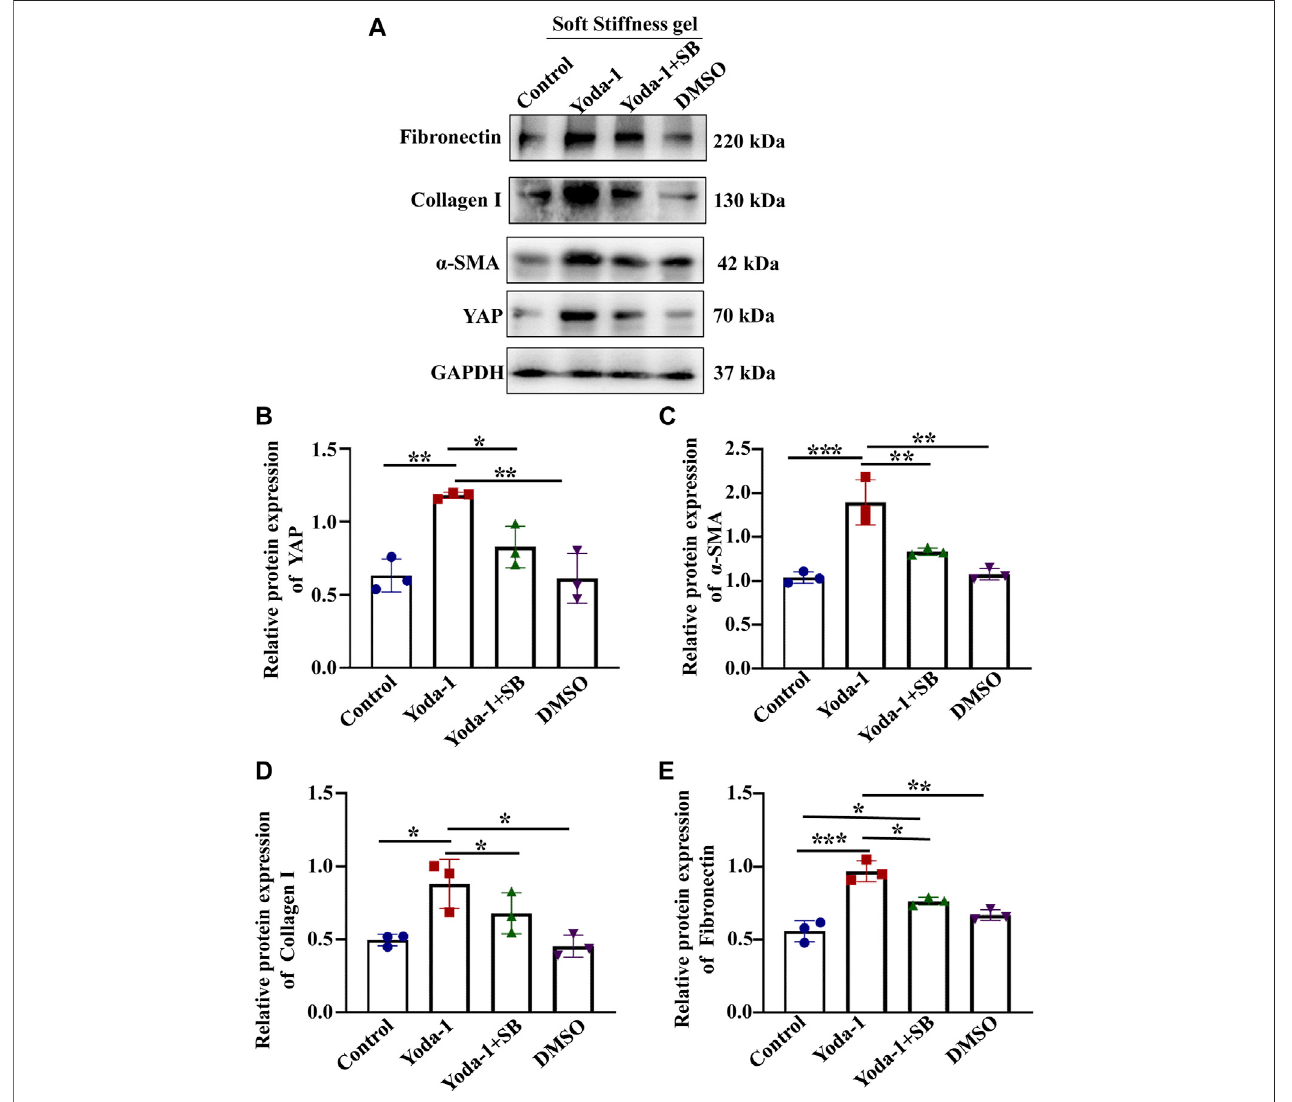
FIGURE7| p38MAPKinhibitor reducedtheincreasedYAPexpressionandECMsecretioninducedbyPiezo1activator. (A) MCswereincubated withYoda-1and SB for 48 h on the soft gel. (A) Representative western blot bands represent the protein expression levels of Fibronectin, Collagen 1, α -SMA and YAP. The bar graph shows the result of semi-quantitative measurement of Fibronectin (B) , α -SMA (C) , Collagen I (D) and YAP (E) . ( n (cid:1) 3; * p < 0.05, ** p < 0.01, *** p < 0.001).